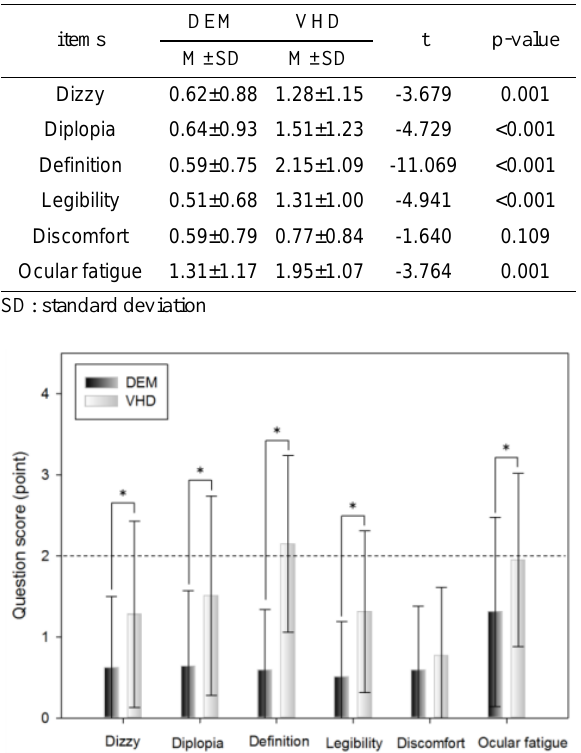
Figure 8. Subjective symptoms (*: p<0.05)